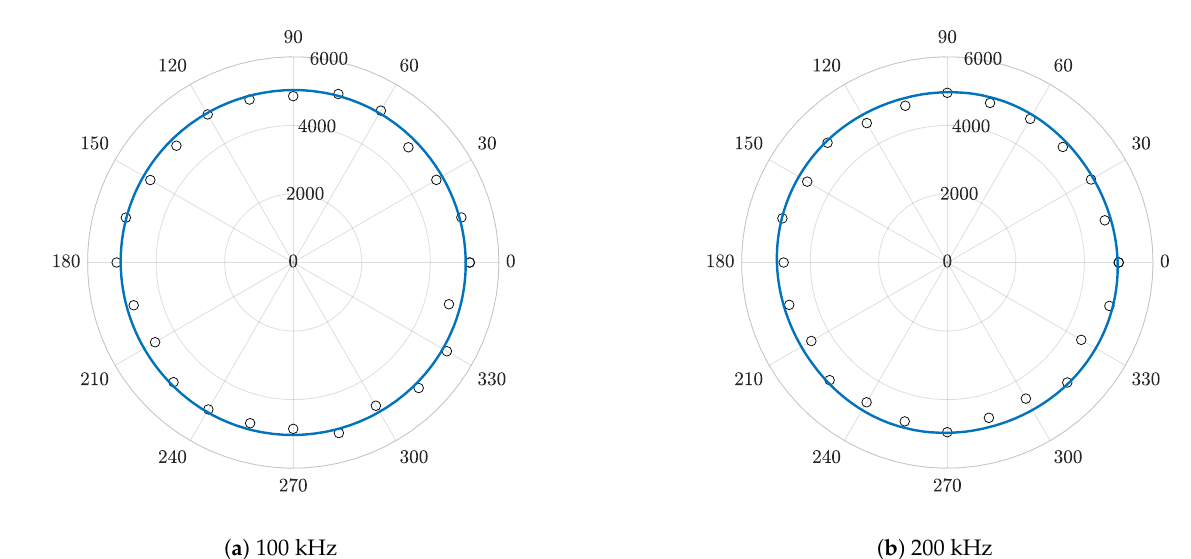
Figure 9. Group velocity curves for [+ 45/0/ − 45/90/ + 45/0/ − 45/90 ] s laminate from experiments (o) and the WFE (–)